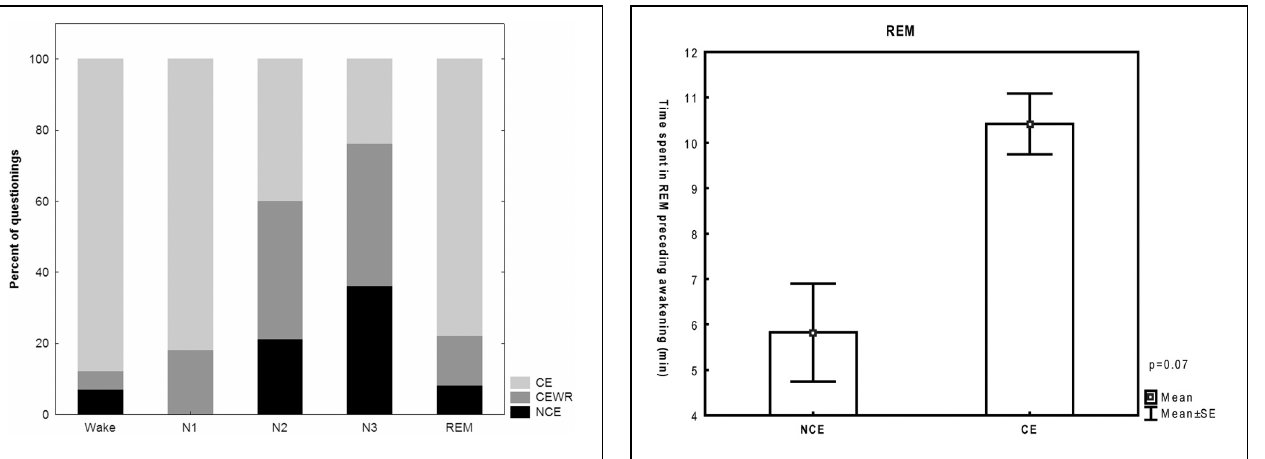
FIGURE 6 | Time spent in REM sleep (mean and standard error of mean) for questionings associated with conscious experiences (CE) and no conscious experiences (NCE) in REM sleep (four subjects). Paired t -test. ∗ p = 0 .